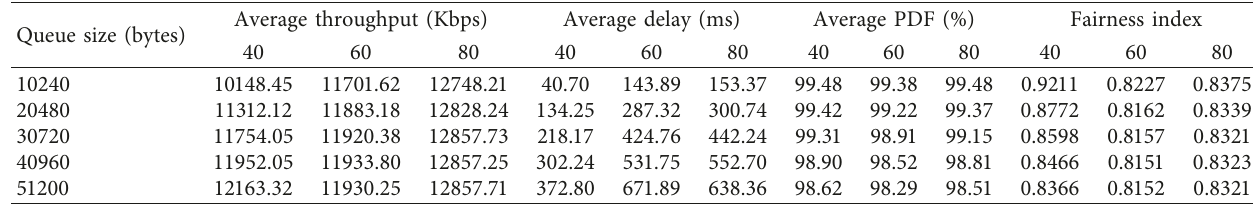
Figure 3: Performance of users with the autotuning method for varying receiver window sizes. (a) Average throughput. (b) Average delay. Table 2: Performance of the system for varying queue size of the users at